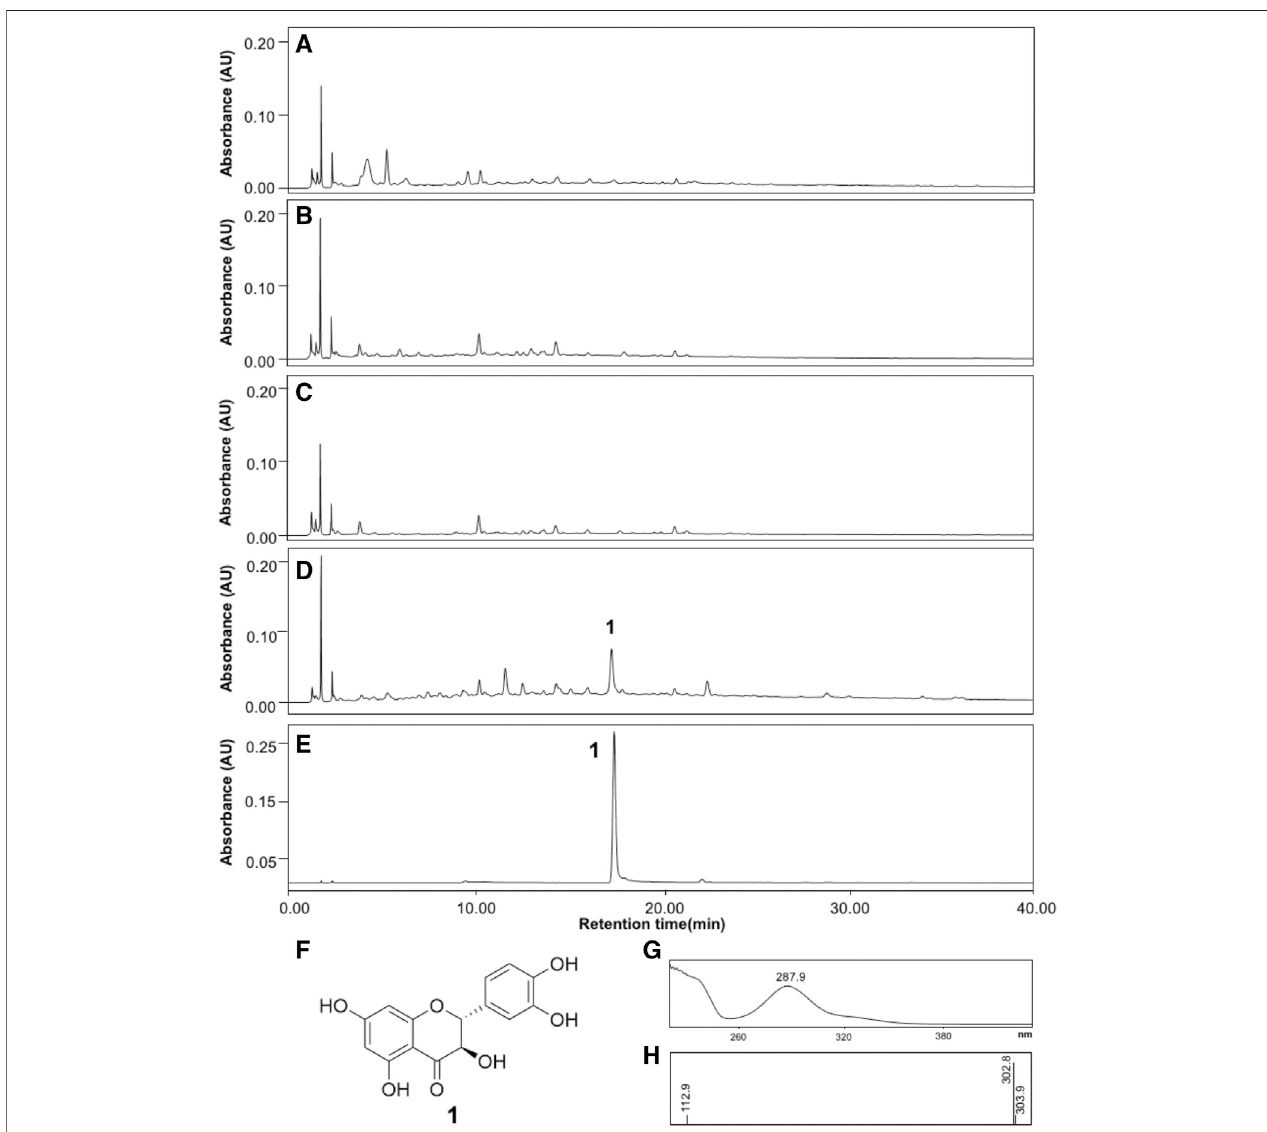
FIGURE 4 | HPLC pro fi les of the four RBEs and taxifolin. (A) Black RBE, (B) Brown RBE, (C) Green RBE, (D) RRBE and, (E) Taxifolin. (F) Structure of taxifolin, in addition to (G) UV and (H) MS spectra of the major RRBE and taxifolin peaks recorded in the chromatogram.